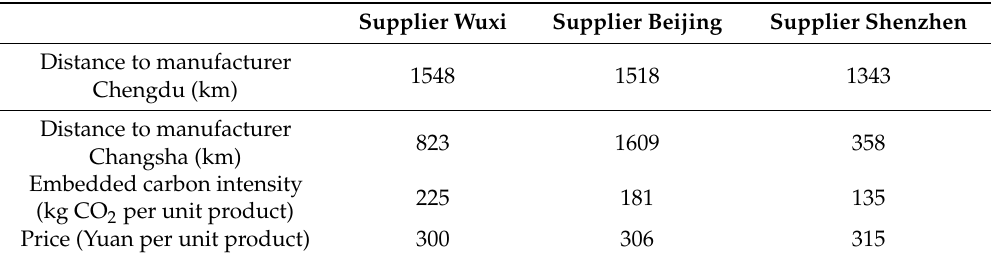
Table 5. The values of some relative